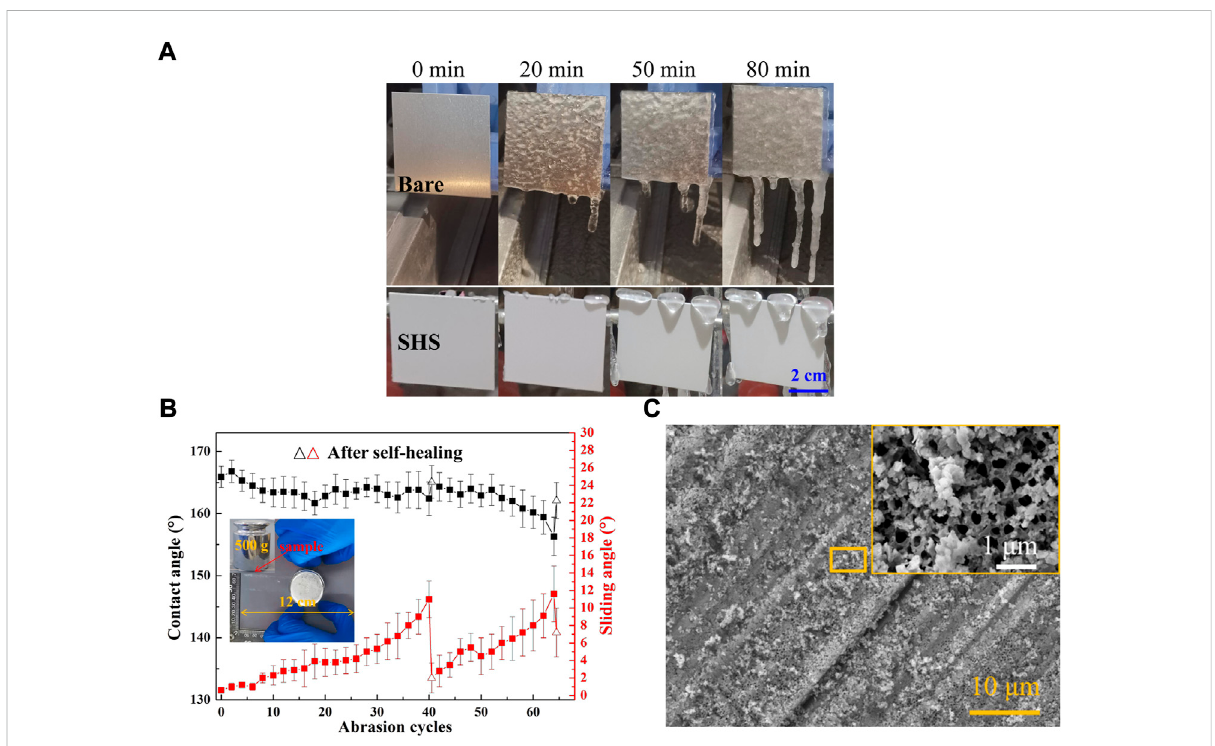
FIGURE 3 (A) The images of ice formation on bare Al plate and the as-prepared SHS (Liu et al., 2022). (B) Contact angle and sliding angle for water on the SHS after abrasion cycles and self-healing treatment (Liu et al., 2022). (C) The SEM images of the SHS after being abrasion for 7.68 m. The inset was the larger magni fi cation (Liu et al.,